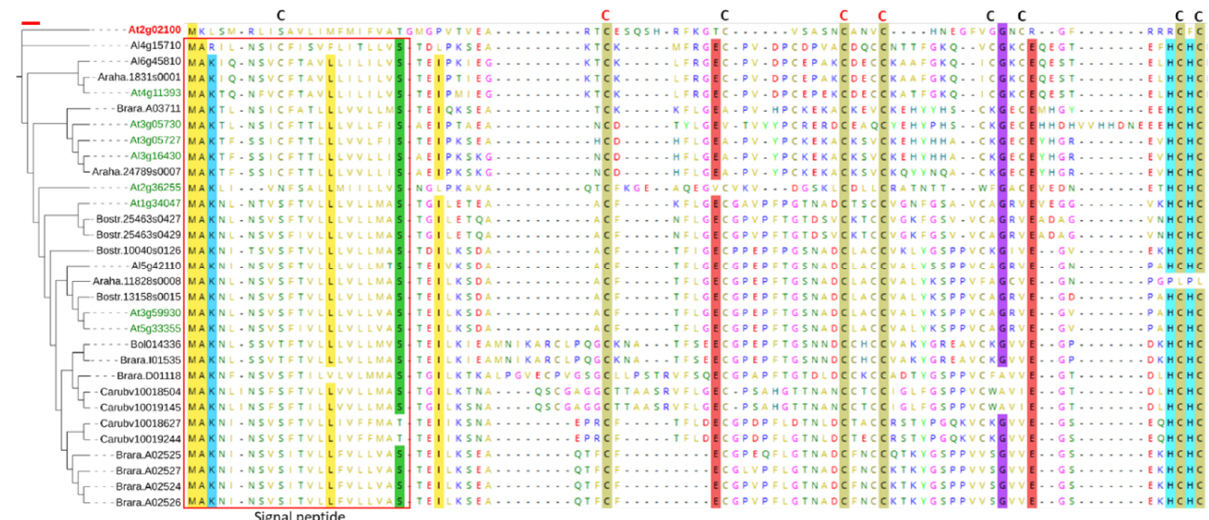
Figure 5. Maximum likelihood (ML) tree of homologs of At3g59930 . The tree was constructed by aligning the peptides of homologs in MEGA v. 7.0 using the built-in MUSCLE algorithm for multiple sequence alignment. The alignment was then exported to iQTree. ModelFinder was used to find a model of substitution, which was WG + G4. The ML tree was then constructed based on the selected model with ultrafast bootstrap and 1000 replicates. At2g02100 (a plant defensin gene) was used as an outgroup to root the tree. The red scale on the top of the tree represents the tree scale = 0.1. Red box shows the conserved signal peptide. Letters C on the top of alignment show conserved cysteine residues, with red colour indicating 100% conservation across all the entries. The highlighting with different colors represent residues that are conserved in >90% entries.